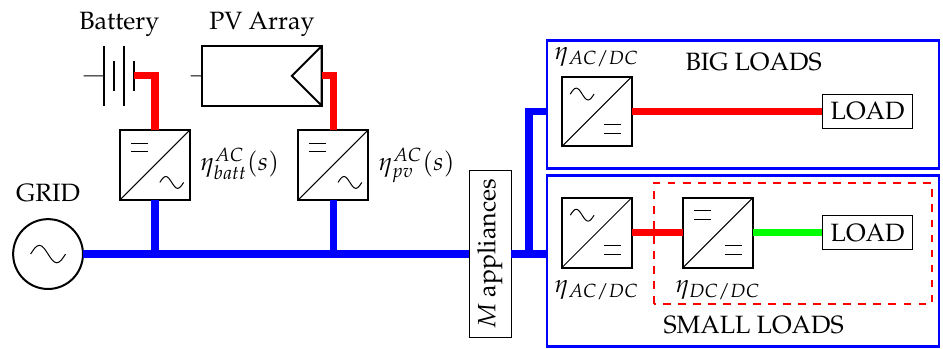
Figure 1. Modelled AC distribution topology with an AC coupled PV and battery systems.